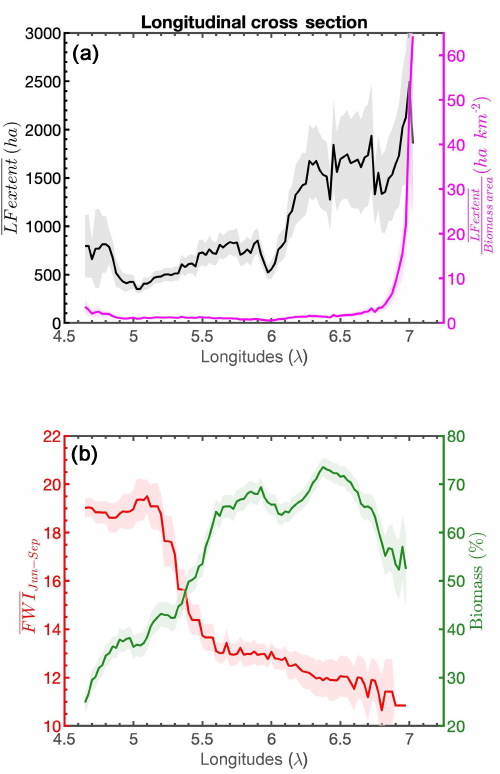
Figure 4. (a) Longitudinal cross section of mean LF extent (ha) computed over 30km sliding windows (in black). The magenta line indicates the mean LF extent normalized by the biomass area (ex- pressed in square kilometers). The 95% confidence intervals were estimated using a bootstrapping approach. (b) Same as (a) but for mean June–September FWI (in red) and the percent of biomass (in